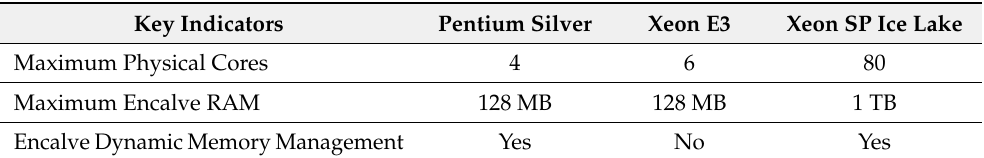
Table 8. Key Indicators of Enclaves on Different CPU Platforms.